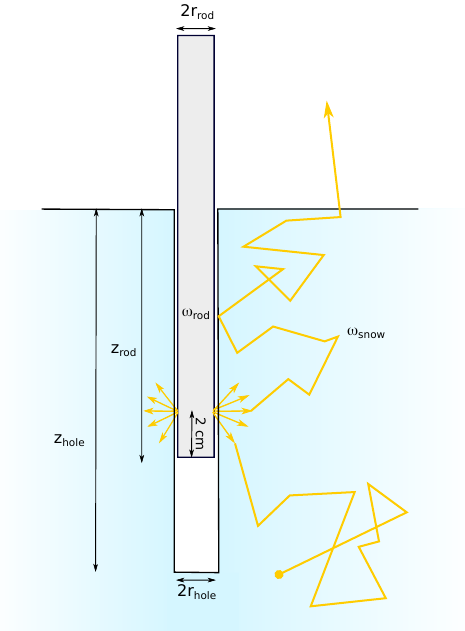
Figure 3. Principle of the 3-D radiative transfer model MCML adapted to snow. The rod (gray) is a cylinder of diameter 2 r rod in- serted down to z rod depth in the hole. The hole is also a cylinder of diameter 2 r hole and extends up to z hole depth in the snow. Rays (or- ange) are launched from the sensor entrance, which is located 2cm above the end of the rod and backpropagated. They eventually reach the surface or are discarded when their energy is lower than a small portion of its initial value (10 − 5